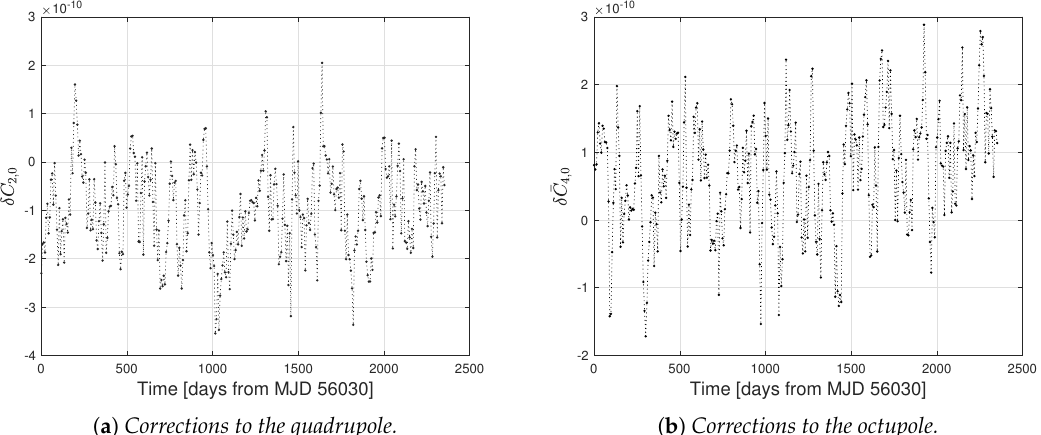
Figure 2. Corrections to the quadrupole ( ¯ C 2,0 ) and octupole ( ¯ C 4,0 ) coefficients estimated, arc by arc, on the time span of our analysis. The GGM05S model was considered for the background gravitational field of the